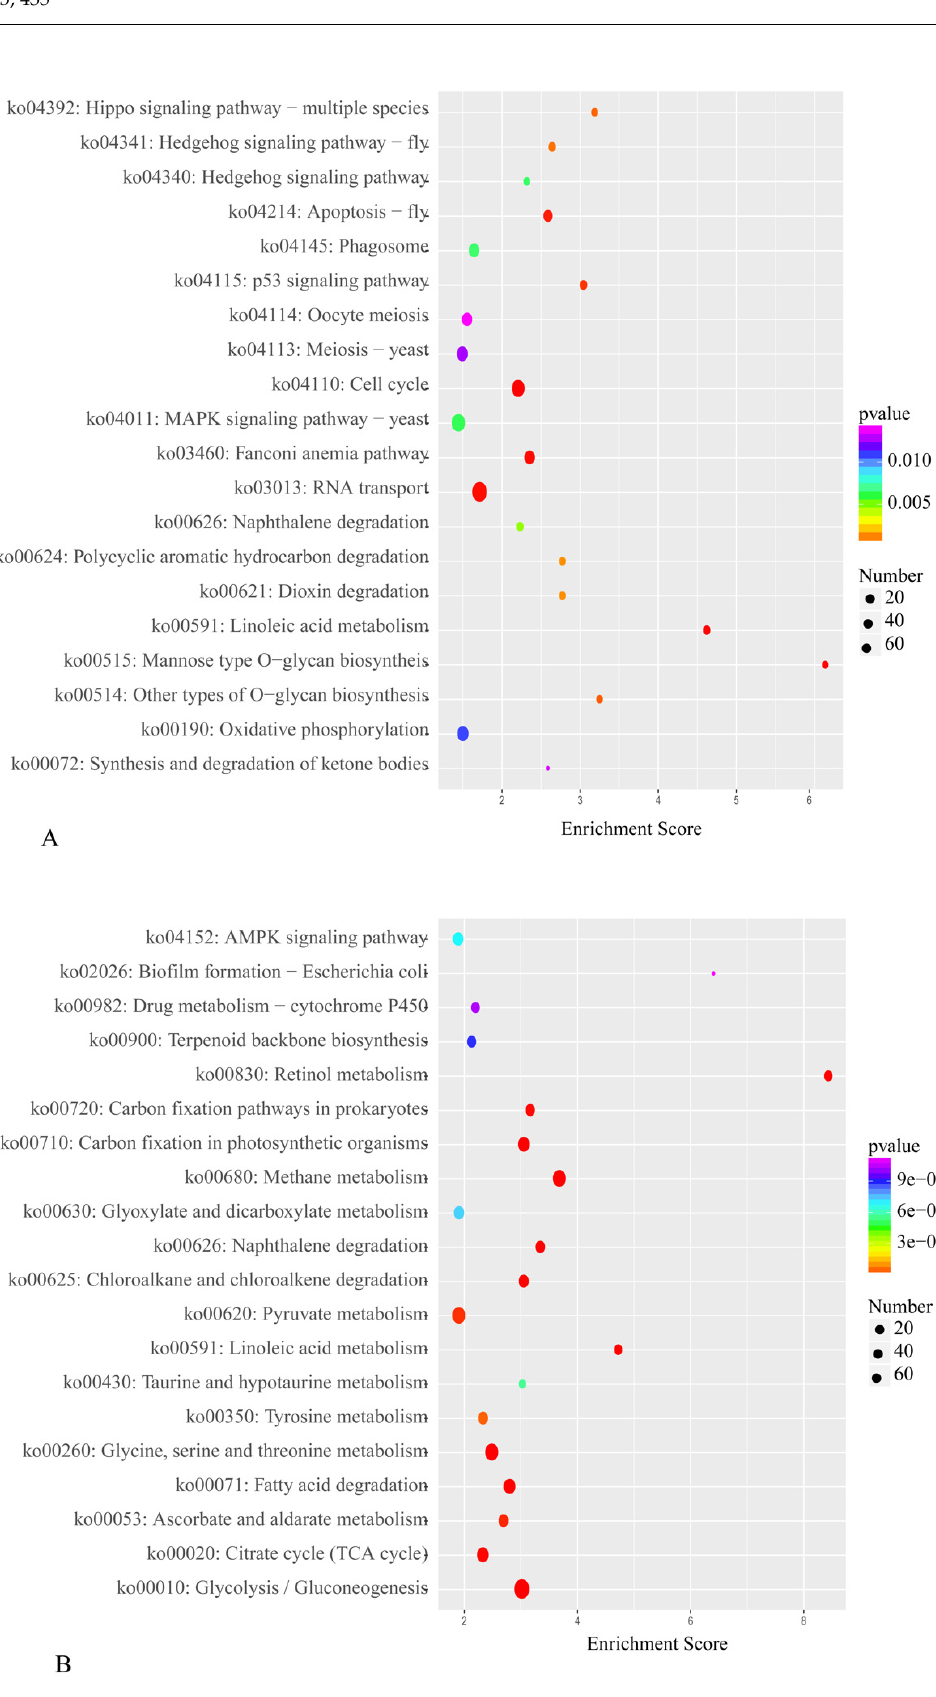
Figure 8. The top 20 enriched KEGG pathways from R vs. B. ( A ). Enriched KEGG pathways of downregulated DEGs. ( B ). Enriched KEGG pathways of upregulated DEGs. The color intensity is proportional to the enrichment significance, and the circle size indicates the number of enriched genes.